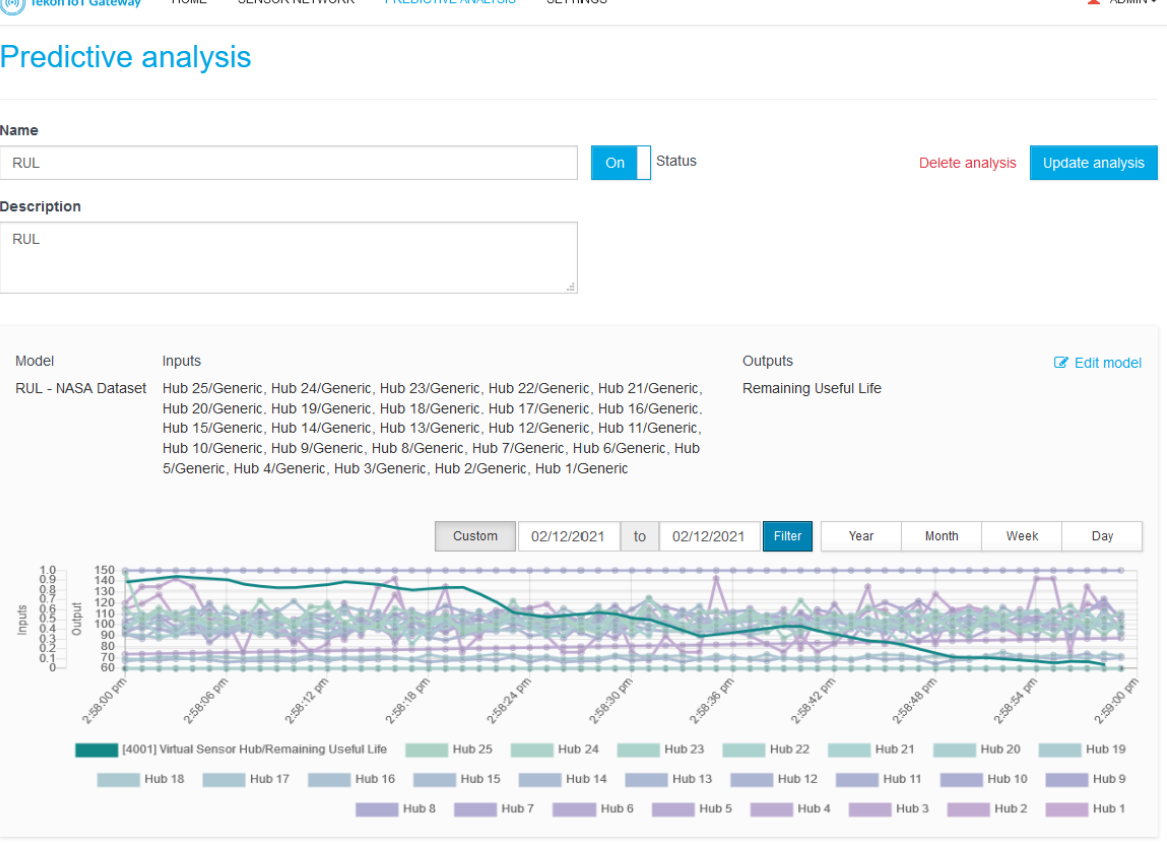
Figure 7. Predictive Analysis Details. In this screen, the TIP4.0 web interface lists the Predictive Analysis name, description, status, Model, and Model configuration (inputs and output data). A plot with the behaviour over time of the sensor used as input for the Predictive Analysis along with the corresponding Model output is also